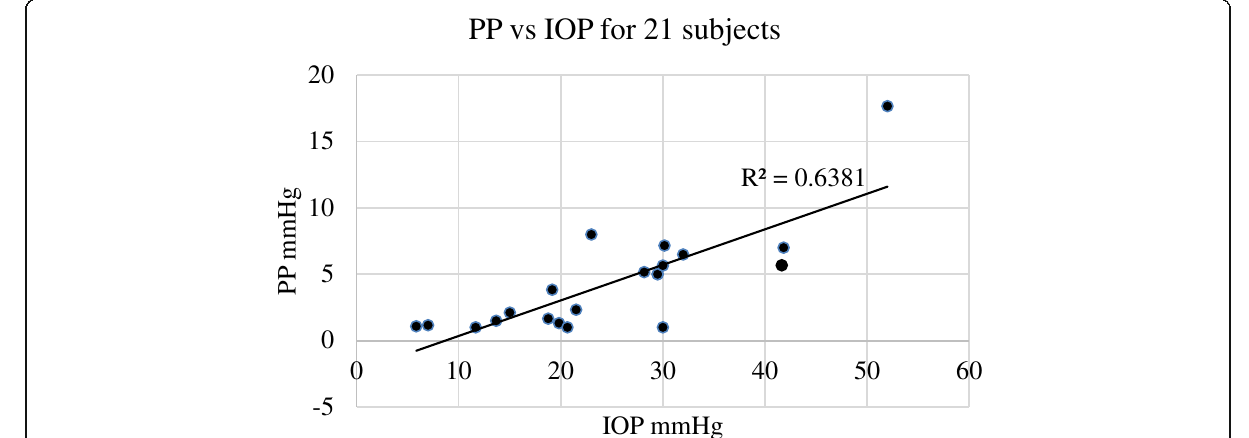
Fig. 1 Showing the relationship between basal IOP and basal PP. IOP is proportional to the PP, Pearson correlation R 2 =